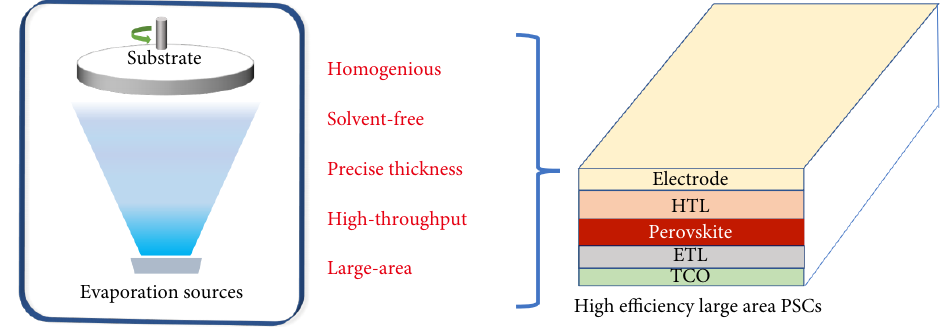
Fig. 1 Evaporation scheme and its merits, and the structure of perovskite solar